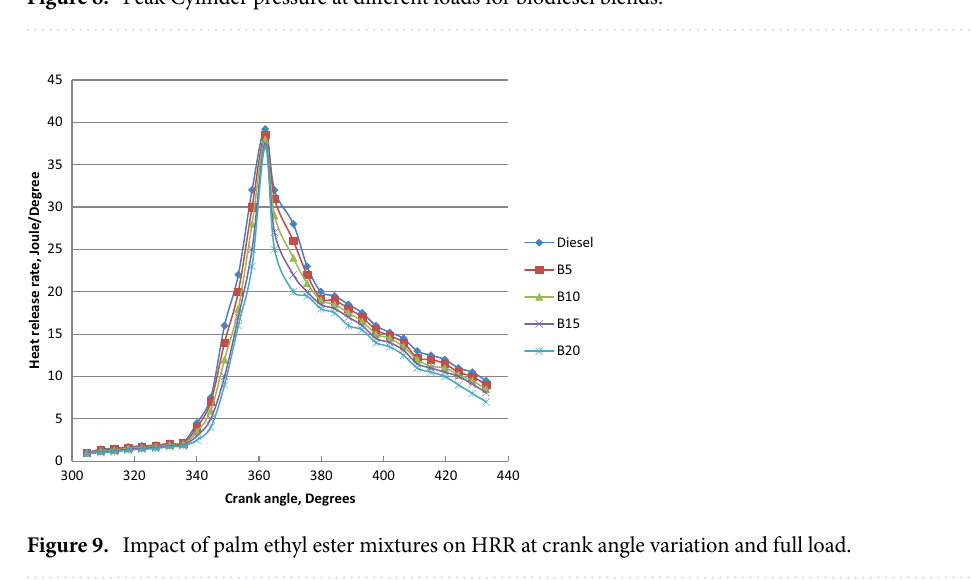
Figure 8. Peak Cylinder pressure at different loads for biodiesel blends.